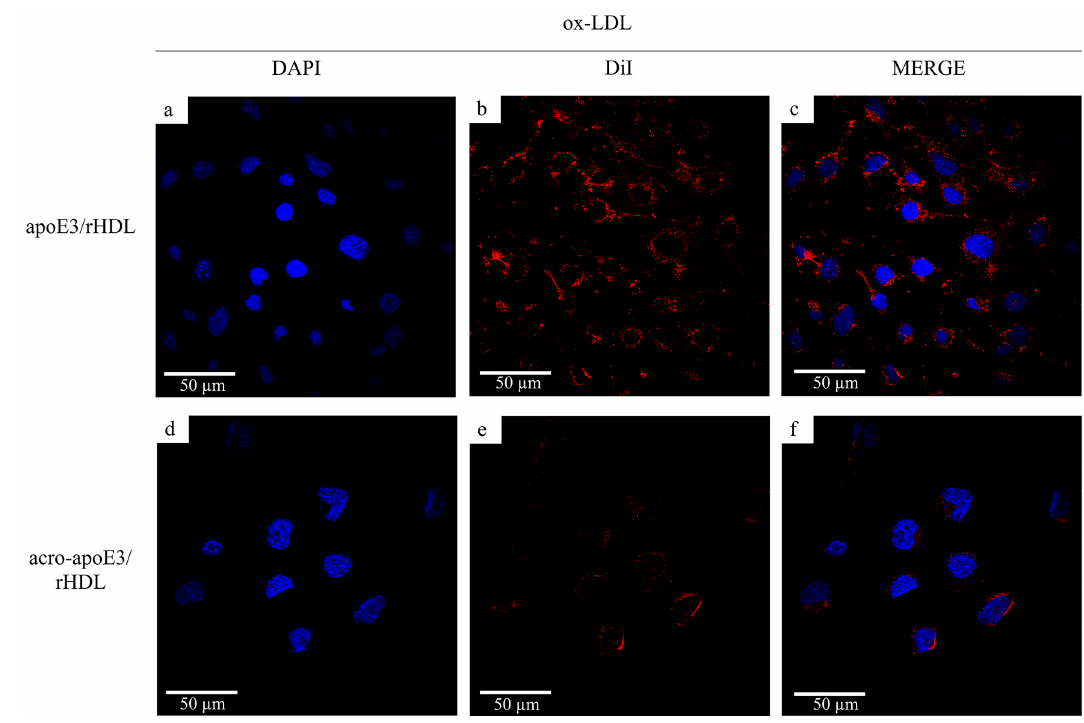
Figure 6. Uptake of apoE3/rHDL and acro-apoE3/rHDL in the presence of ox-LDL. Uptake experiments were carried out as described earlier with 3 µg/mL apoE3/rHDL ( a – c ) or acro-apoE3/rHDL ( d – f ) in the presence of 100× excess ox-LDL (300 µg/mL). The panels show fluorescence of DAPI (a,d), DiI (b,e), and Merge (c,f).